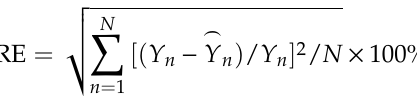
Table 3. Statistical analysis of TS prediction errors. BP-ANN: back-propagation artificial neural network.